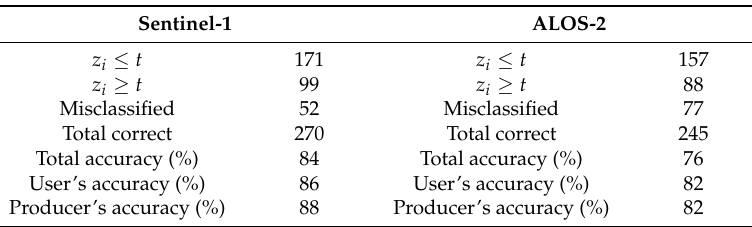
Table 3. Accuracy of building classification according to the discriminant analysis and the binary map for Sentinel-1 and ALOS-2 datasets.